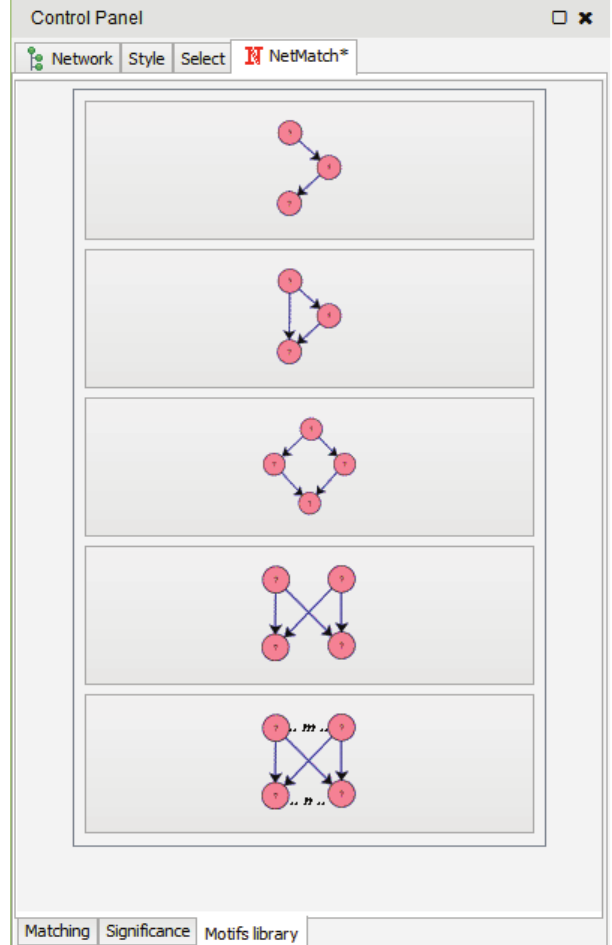
Figure 3. “Motif library” panel in NetMatchStar.